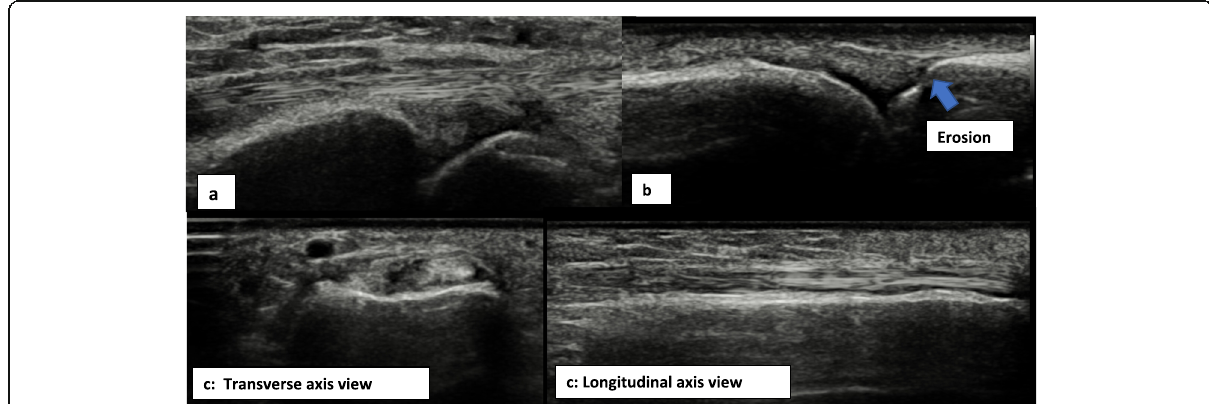
Fig. 2 A 43 years old symptomatic patient, ACPA and anti-dsDNA negative and SLEDAI-2k score of 16. a Right radio-lunate joint with grade 2 SH. b Right 3rd MCP with erosion. c Left 6th extensor compartment grade 2